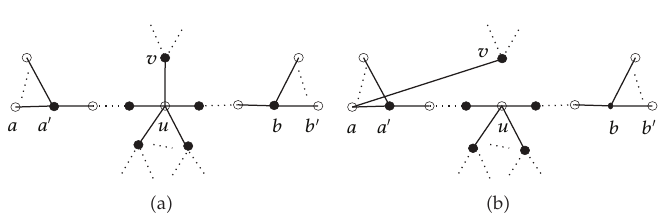
Figure 2: T (cid:2) a (cid:3) and T (cid:8) (cid:2) b (cid:3) in the proof of Claim